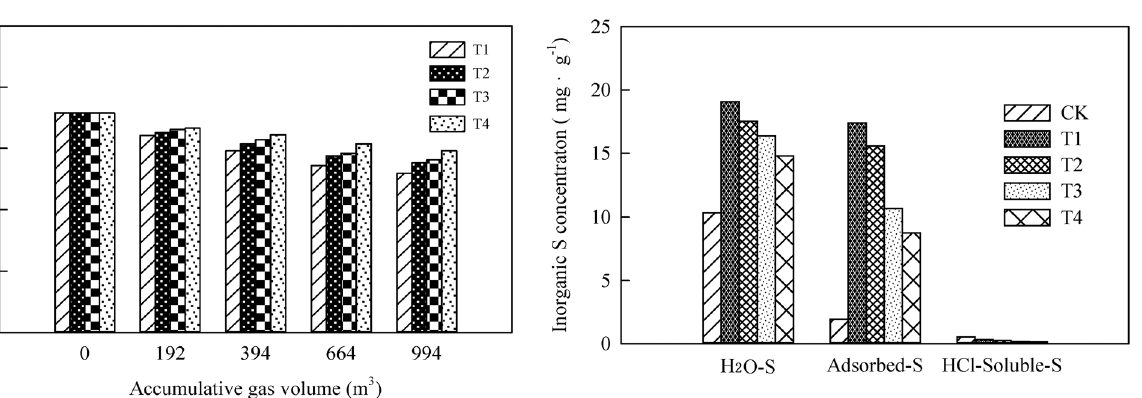
Figure 4: Variation of pH in the four layers of bioreactor packed with vermicompost.